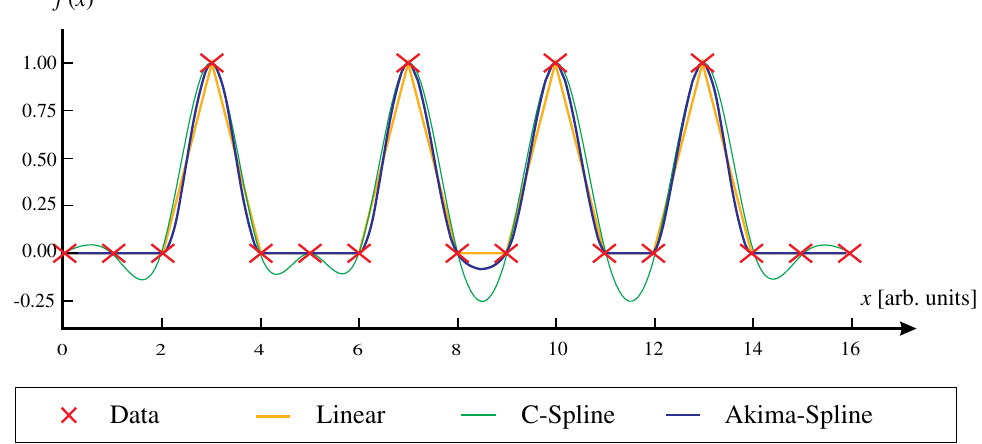
FIG. 7. Comparison of spline interpolations. The given data points are interpolated using linear interpolation, a natural cubic spline (C-spline), and an Akima spline. The C-spline exhibits an oscillatory behavior and strong overshooting. Up to the data point 10, Akima’s original slope estimation was employed [cf. Eq. (50)]. From this point on the minmod slope limiter [cf. Eq. (51)] was applied, which effectively avoids